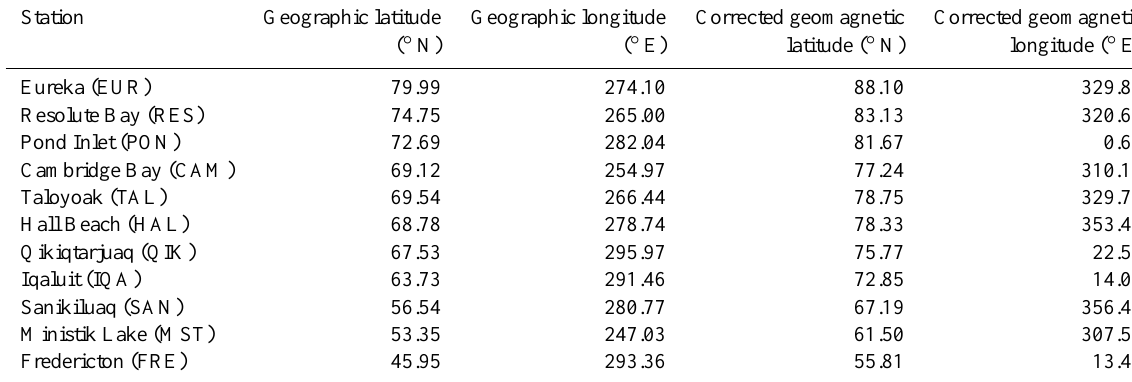
Table 1. Geographic and corrected geomagnetic coordinates of the CHAIN stations.